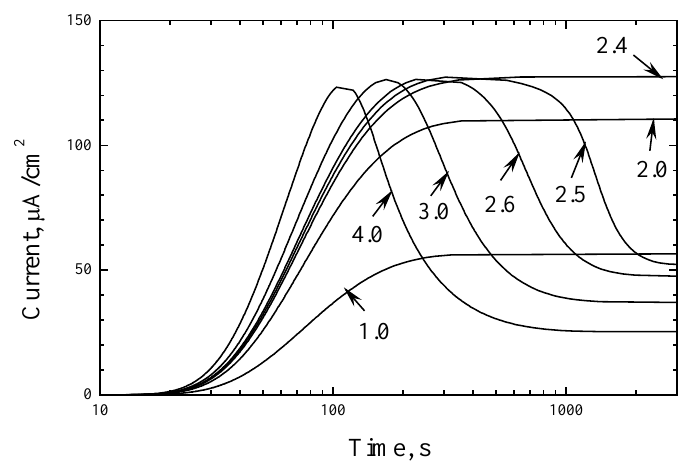
Figure 5 . Kinetics of biosensor response at different values of the normalised substrate concentration. Numbers on the curves show S